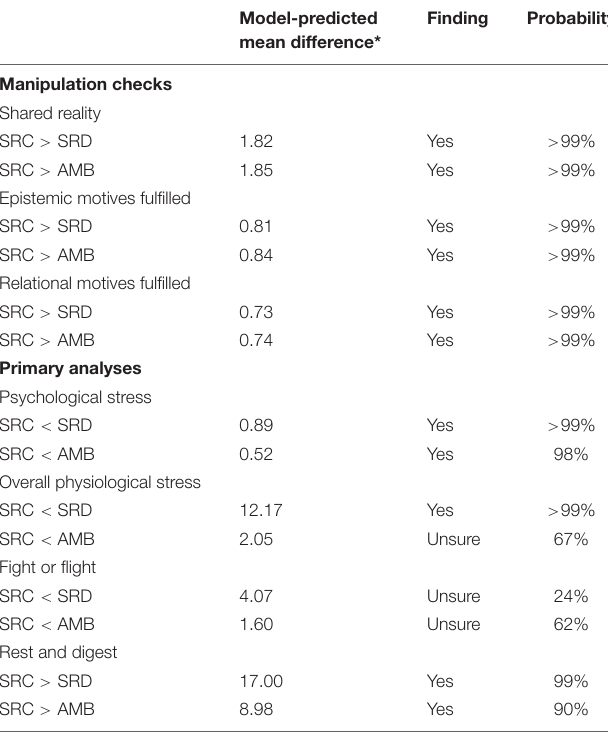
TABLE 1 | Summary of results from Study